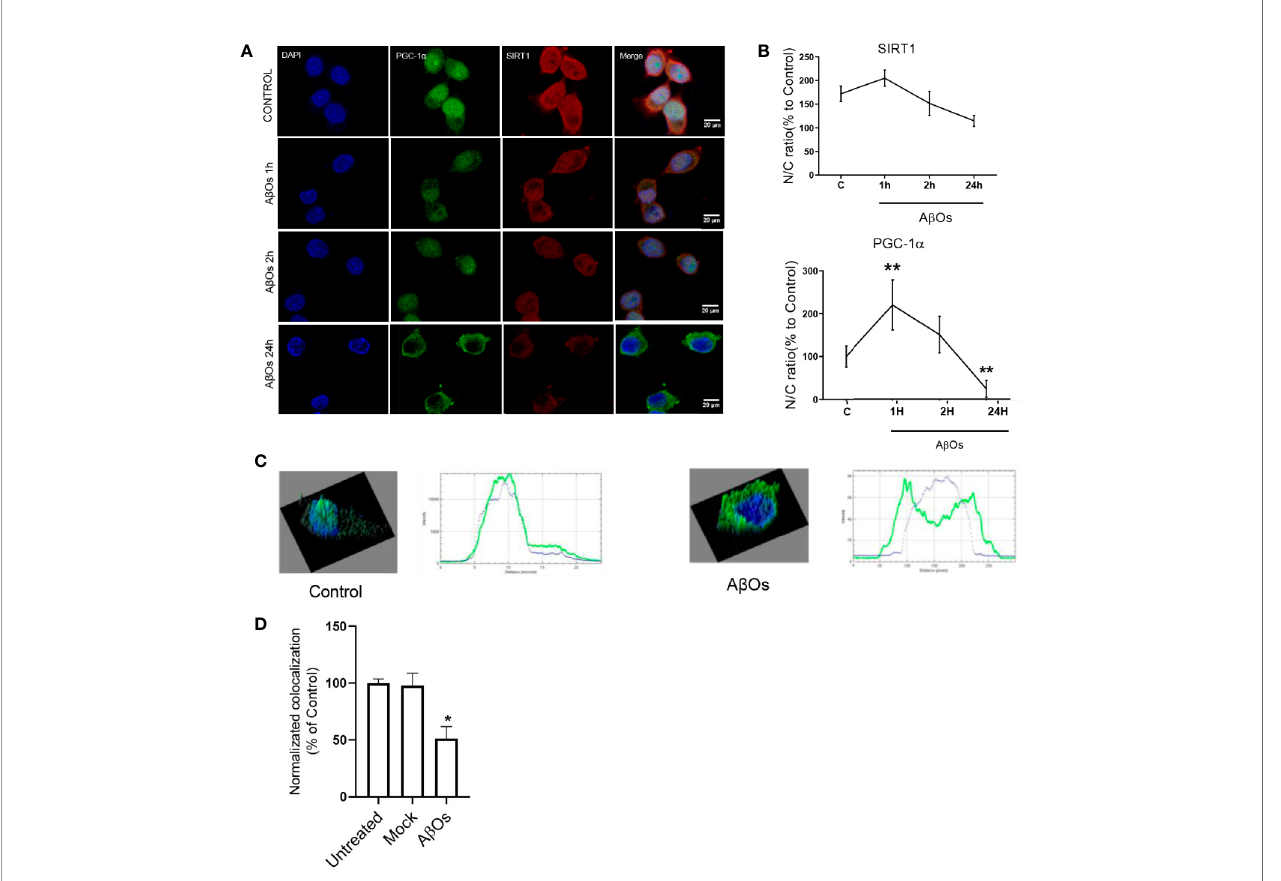
FIGURE 7 | Immunocytochemistry of SIRT1 and PGC-1 a in PC12 cells treated with A b Os. (A) Representative confocal images of PC 12 cells stained with speci fi c primary antibodies for PGC-1 a (Green),SIRT1 (red), and DAPI (blue) in control condition (upper panel), and after A b Os treatments (0.5 µM) during different incubation times (1 and 24 h, lower panels). (B) Quanti fi cation of the nucleus/cytosol ratio (N/C) for SIRT1 (upper graph) and PGC-1 a (lower graph) from images shown in A. (C) Surface plot of a representative cell shown in A, correlating spatial distribution (x,y) with fl uorescence intensity (z) for DAPI and PGC-1 a in control condition (left panel) and after 24 h of treatment with A b Os (right panel). Scale bars: 20 m m. (D) Manders colocalization coef fi cient (MCC) values quantify the different levels of colocalization between PGC-1 a and SIRT1. Data are represented as mean ± SEM. *p < 0.05, **p < 0.01, compared between the control group. One-way ANOVA with the Dunn's multiple comparisons test was used for all statistical analyses. PGC-1, Peroxisome proliferator-activated receptor gamma coactivator 1-alpha; SIRT1, silent information regulator 2 homolog 1. (n=3,